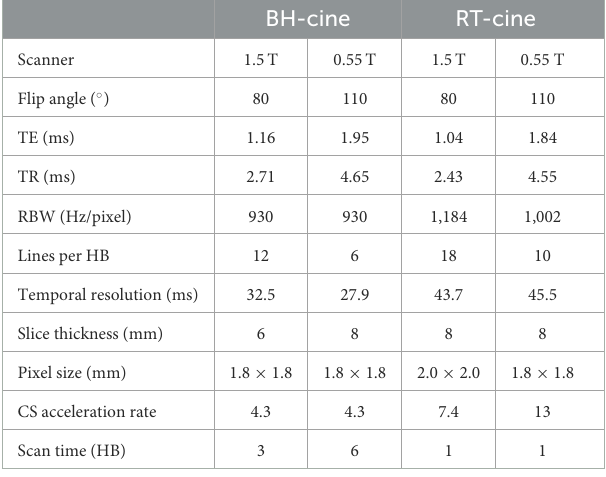
TABLE 1 Cine acquisition parameters for 0.55T in comparison to